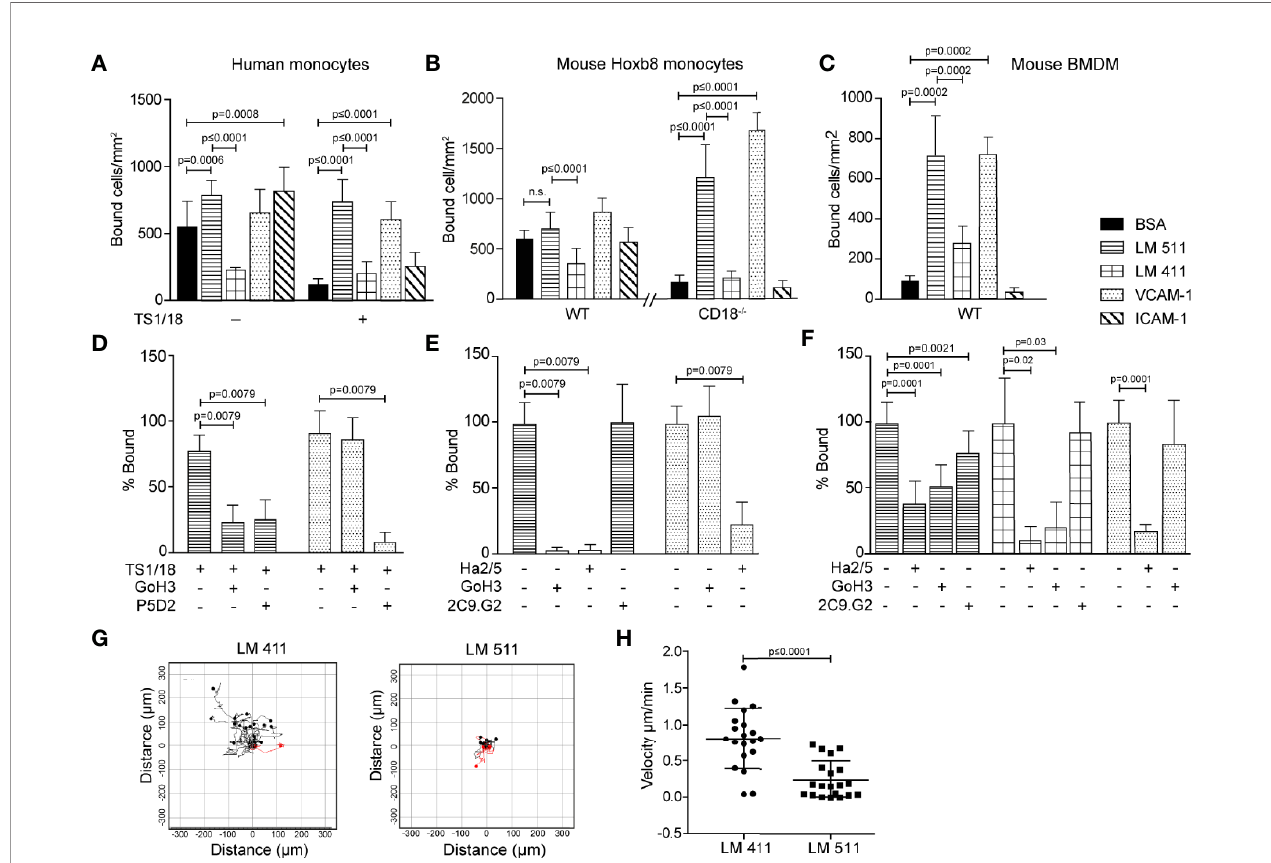
FIGURE 3 | Human monocytes, mouse monocyte-like Hoxb8 cells and mouse bone marrow derived macrophages (BMDM) bind differentially to endothelial laminins. Human monocytes (A, D) , mouse monocyte-like Hoxb8 cells (B, E) and BMDM (C, F) adhesion to laminins 411, 511, VCAM-1, ICAM-1, or BSA. To exclude non- speci fi c integrin b 2-mediated adhesion of monocytic cells, experiments were performed with untreated or integrin b 2 antibody (TS1/18) treated human monocytes, and WT and CD18 − / − mouse monocyte-like Hoxb8 cells. Adherent cells were counted at 1 h and expressed as number of bound cells/mm 2 . (D) Inhibition assays were performed with human monocytes preincubated with TS1/18 and either anti-integrin a 6 (GoH3) or b 1 (P5D2) antibodies before addition to substrates. Similar experiments were performed with mouse monocyte-like CD18 − / − Hoxb8 cells (E) and BMDM (F) pre-incubated with anti-mouse integrin b 1 (Ha2/5), a 6 (GoH3), or b 3 (2C9.G2) antibodies. Data in (D – F) are expressed as percent of total cells bound in the absence of blocking antibodies. All data except (F) are means ± SD from four to fi ve independent experiments with triplicates/experiment; (F) are means ± SEM of three experiments with triplicates/experiment. (G) Random migration of BMDM on laminin 411 and laminin 511 were imaged by time-lapse video microscopy; >20 cells on each substrate were tracked and analyzed, and (H) velocity of migrating cells on each substrate; data are means ± SD from a representative experiment. The experiment was performed three times with similar results. Signi fi cance was calculated using a Mann-Whitney test in (A, C, D, E, H) , a Welch ’ s t-test in (B) , and an unpaired t-test in (F) ; exact p -values are shown in the graph; n. s.= non-signi fi